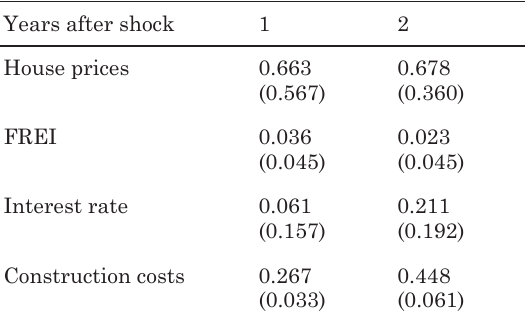
Table 2. responses to an output (GDP) shock